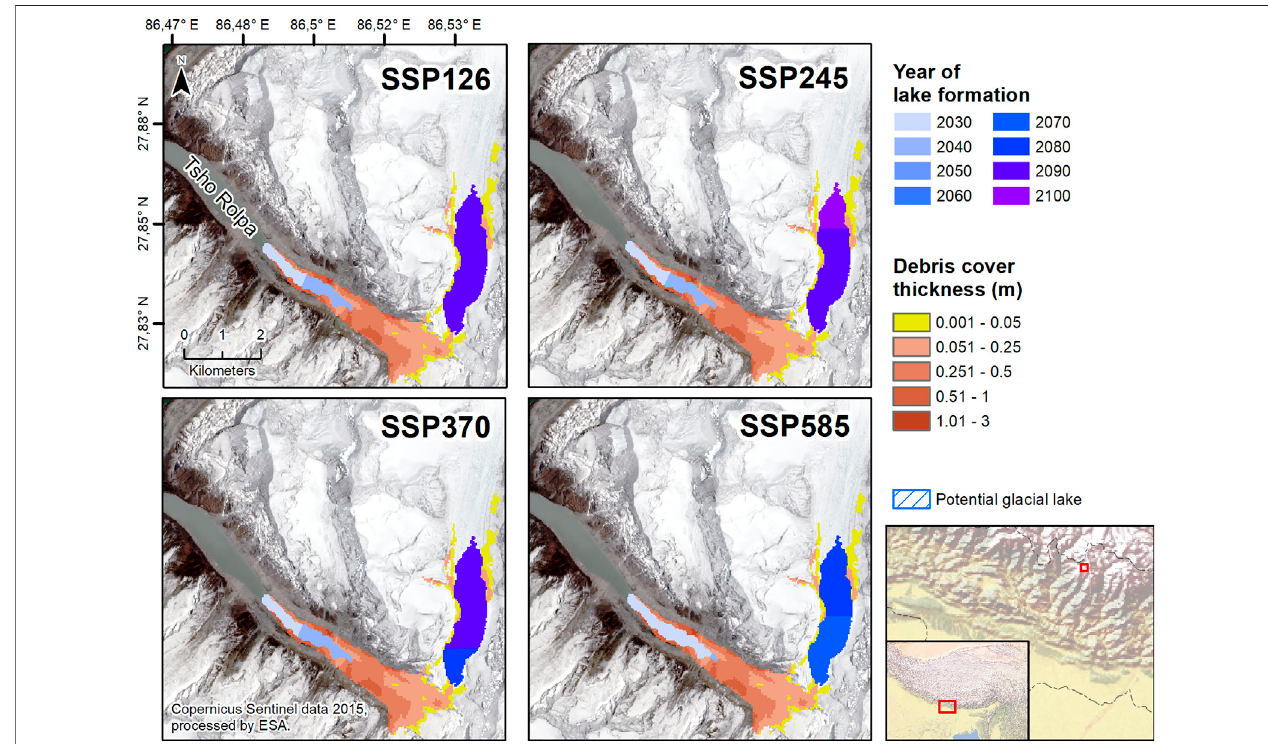
FIGURE10| PotentialextensionofTshoRolpaandformationofasecondlakefurtheruptheglacierunderdifferentSSPscenariosuntil2100.Lakeextentbasedon CESM2-WACCM modeling, debris cover data by Rounce et al. (2021).